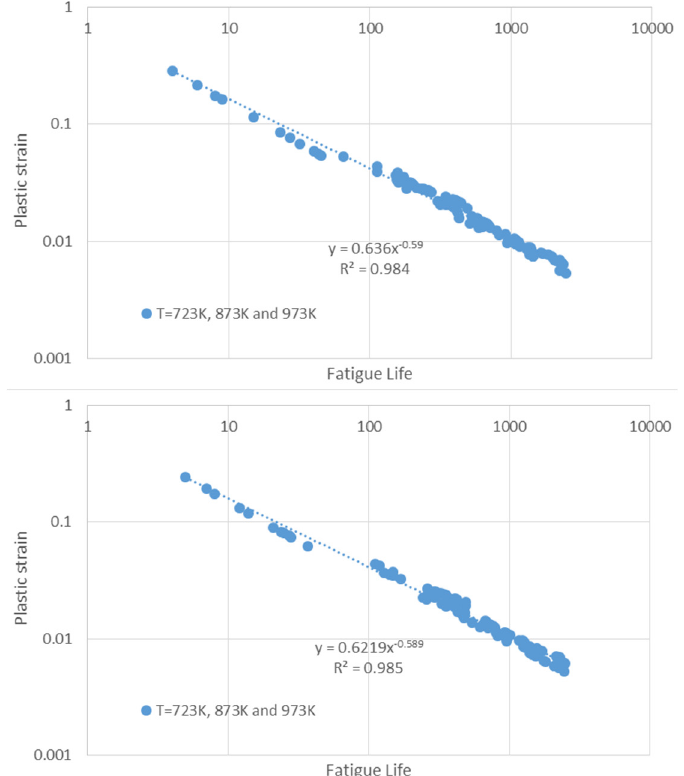
Figure 8. Transformed ε p, ref – N data of stainless steel 316 using Equation (14) with creep function c ( T , t , ε p ) and random variables. Data shown are for two of ten sets, as evidence of a consistent transformation process.